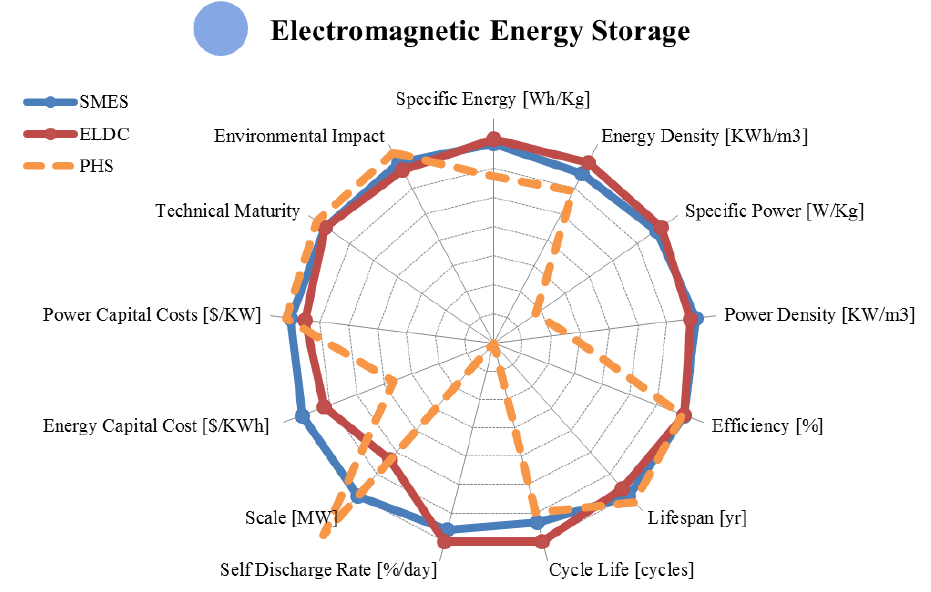
Figure 10. Comparing electromagnetic storage using normalized and logarithmically plotted average data from Table